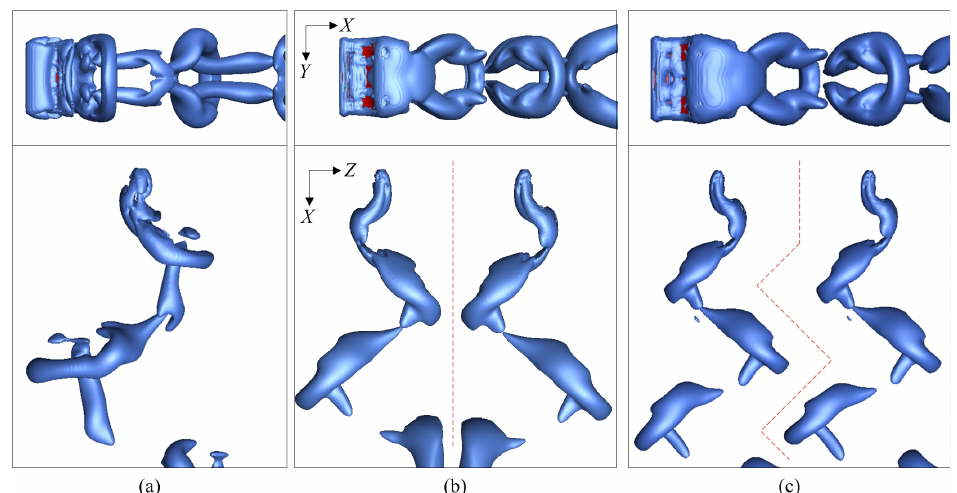
Figure 17. Three typical vortical patterns in the wake of two side-by-side flexible plates ( AR = 1.5): ( a ) single-plate mode ( G z = 0.1); ( b ) symmetrical flapping mode ( G z = 3.0); ( c ) decoupled mode ( G z = 4.0) (Supplementary Video S4 is available online).